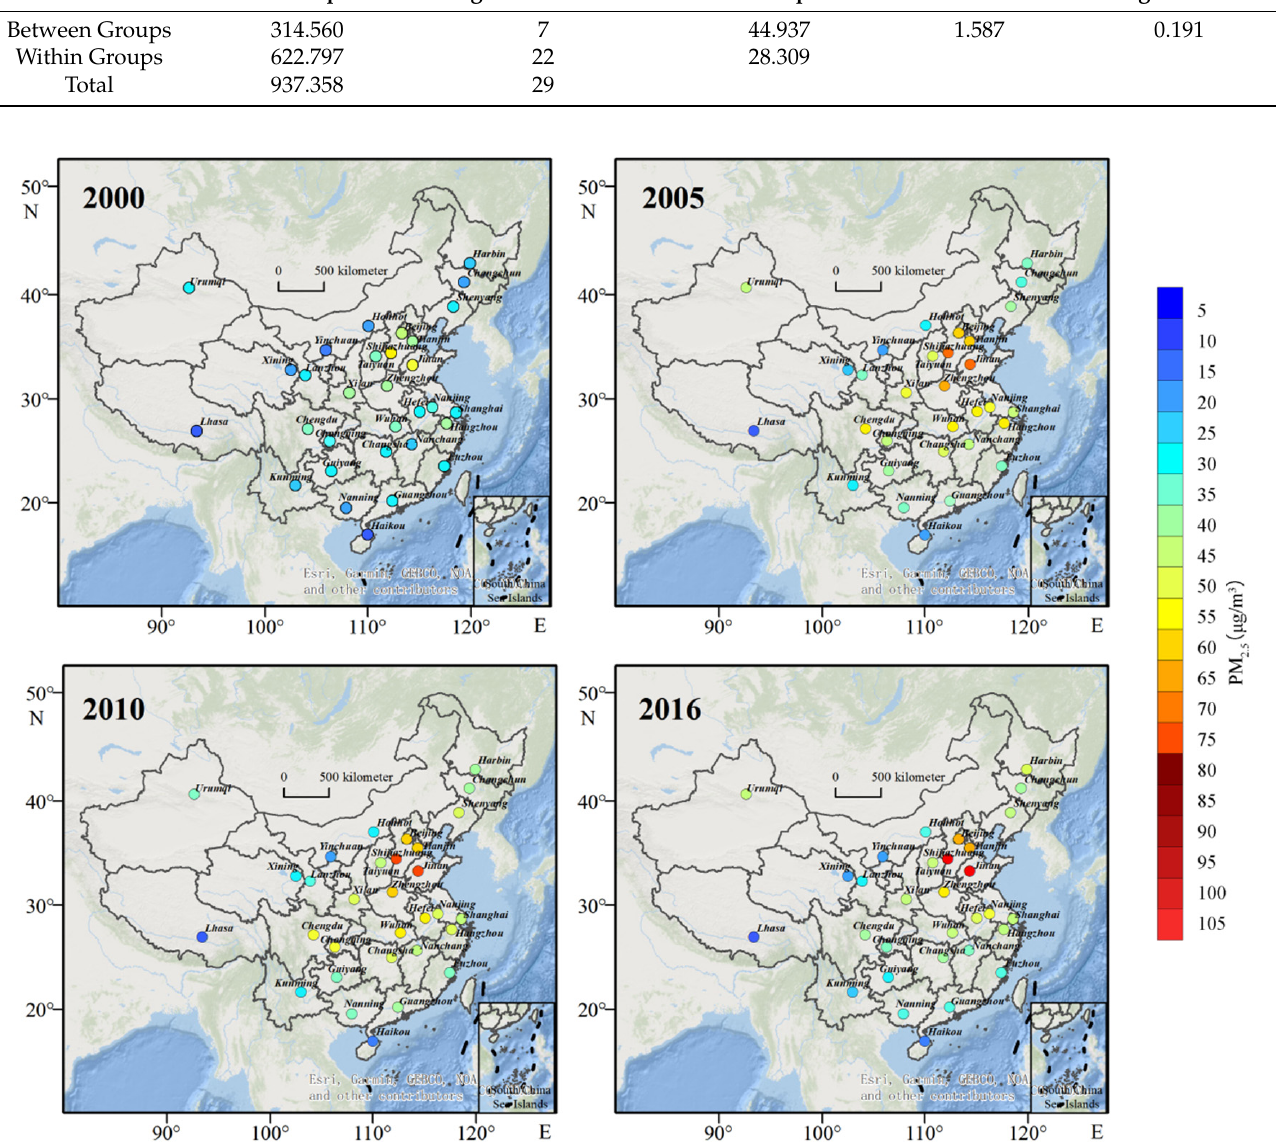
Figure A1. Spatial distribution of PM 2.5 concentration in 31 provincial capital cities during 2000– 2016.